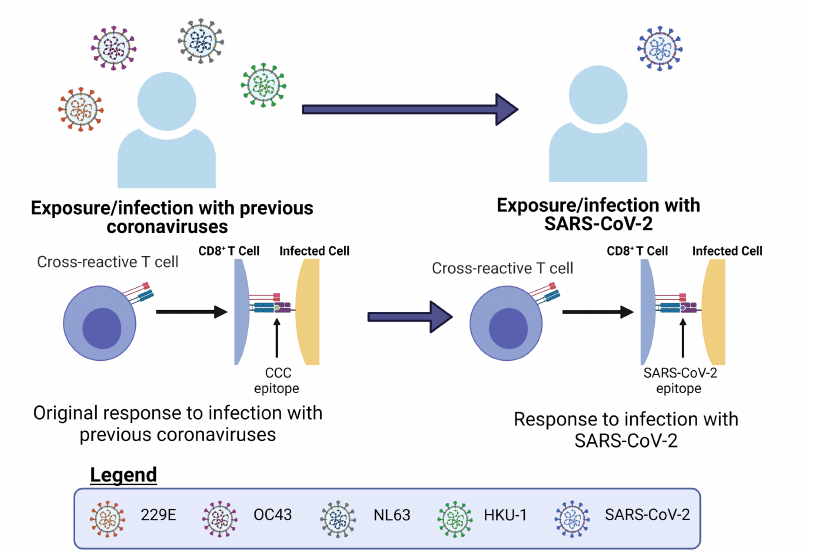
Figure 5. Individuals with previous exposure to common cold coronaviruses (CCCs) most likely have cross-reactive pre-existing immunity to pandemic